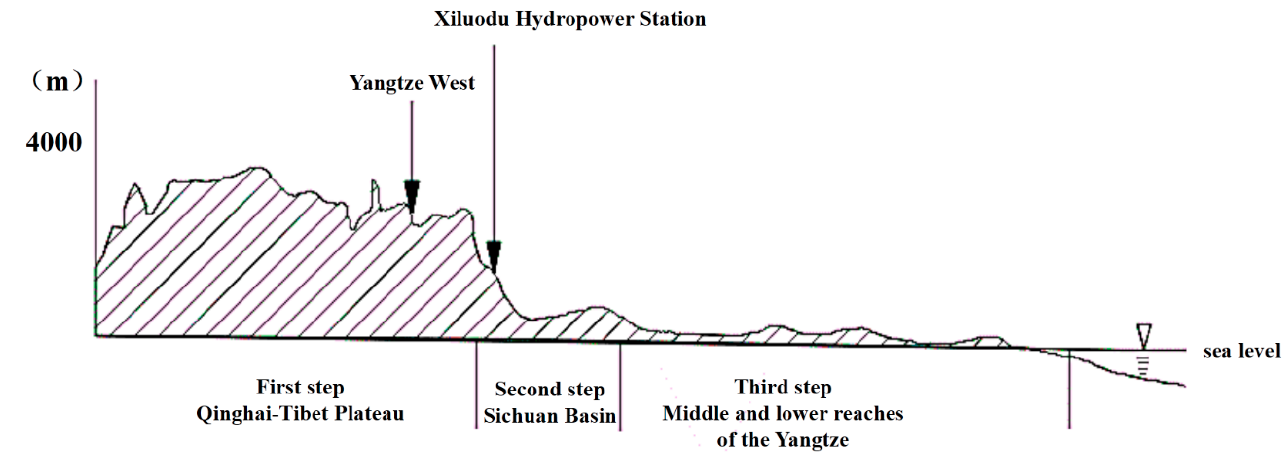
Figure 1. Topography profile of Western—Eastern China.